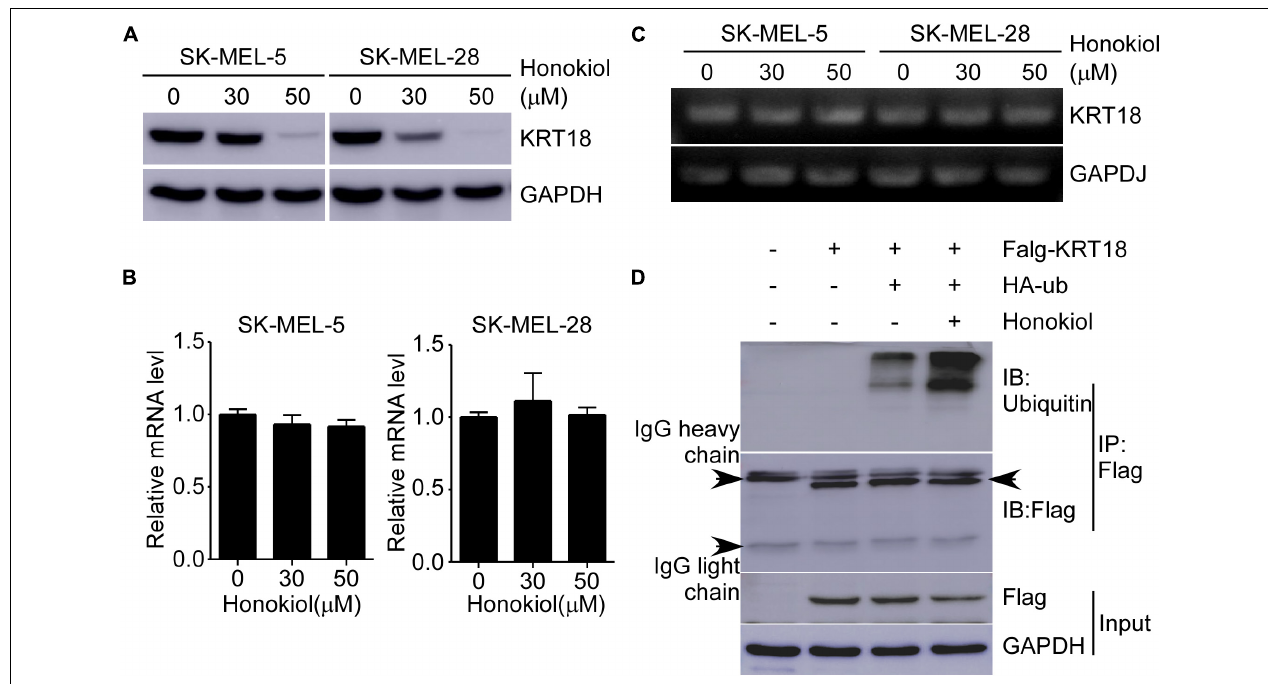
FIGURE 5 | Honokiol down-regulates KRT18 protein levels by inducing its ubiquitination in melanoma cells. (A) Effect of honokiol on KRT18 protein expression in SK-MEL-5 or SK-MEL-28 melanoma cells. Cells were treated with 0, 30, or 50 µ M of honokiol for 48 h and KRT18 protein level was evaluated by western blotting. (B,C) KRT18 mRNA level after honokiol treatment for 48 h was determined by RT-qPCR and agarose gel electrophoresis. (D) Immunoprecipitation of cell lysates from HEK293T cells transfected with exogenous flag-tagged KRT18 and HA-tagged ubiquitin extracts of exogenous flag was followed by immunodetection of exogenous ubiquitin and flag-KRT18. IP Flag: immunoprecipitation with a flag antibody.